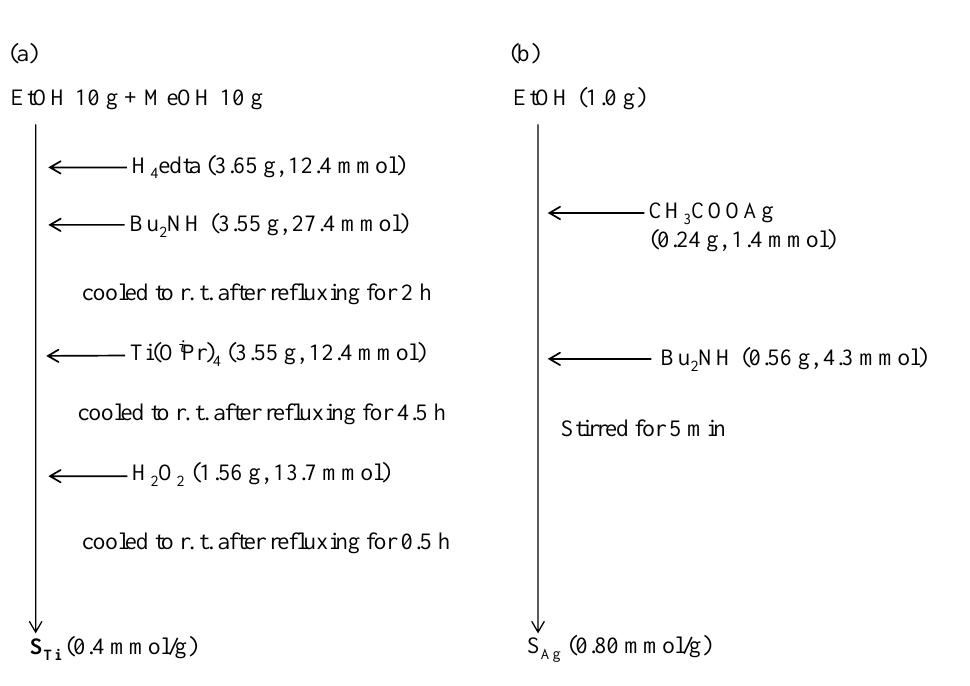
Scheme 1. Preparation procedure of the ( a ) precursor solution STi contains a Ti 4+ complex of EDTA and ( b ) precursor solution, SAg containing silver